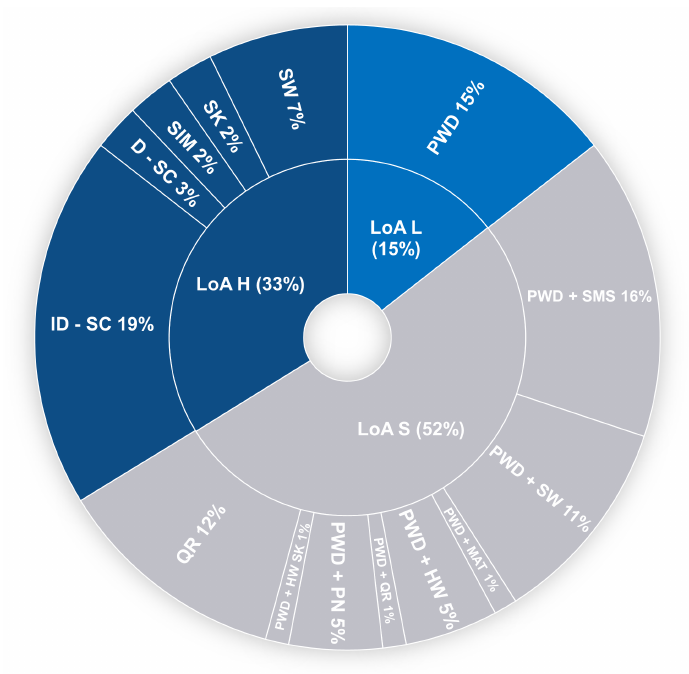
Figure 4. Overview of Authentication Mechanisms based on LoAs adopted by